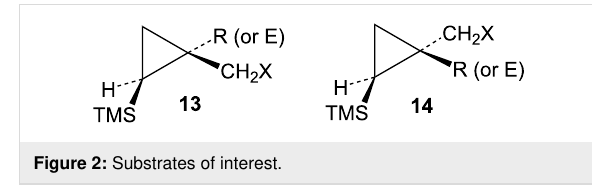
Figure 2: Substrates of